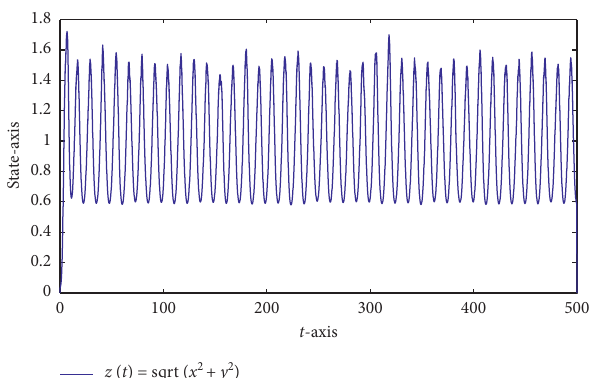
Figure 3: Stochastic persistence of (5) with n � 1 and x ( 0 ) � y ( 0 ) � 0 .